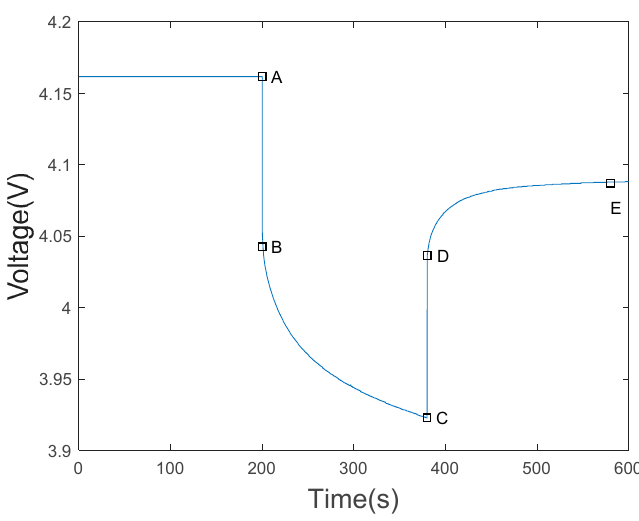
Figure 4. Partial enlargement of pulsed discharge voltage.